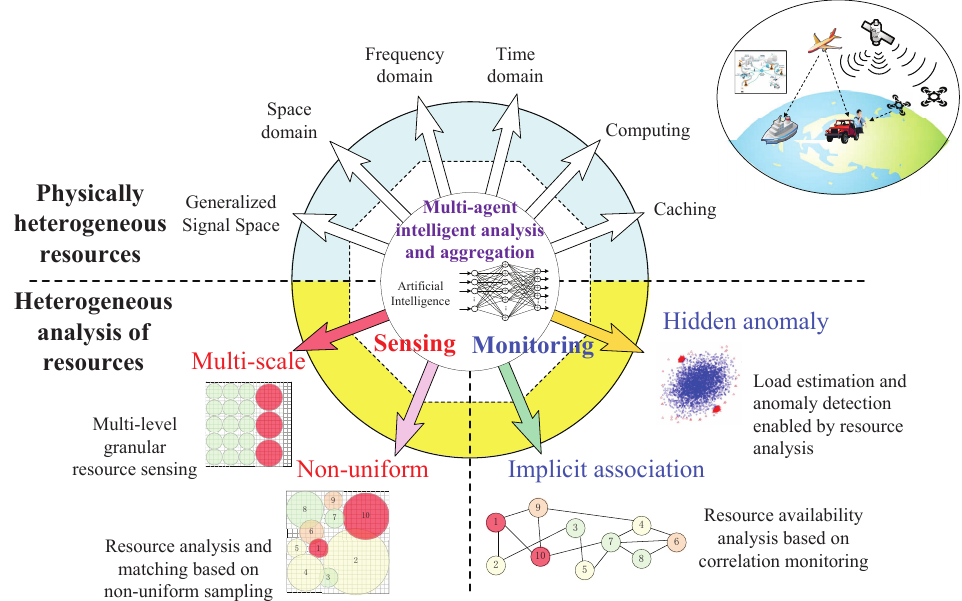
Figure 7. Heterogeneous resource analysis and aggregation via intelligent sensing and monitoring.